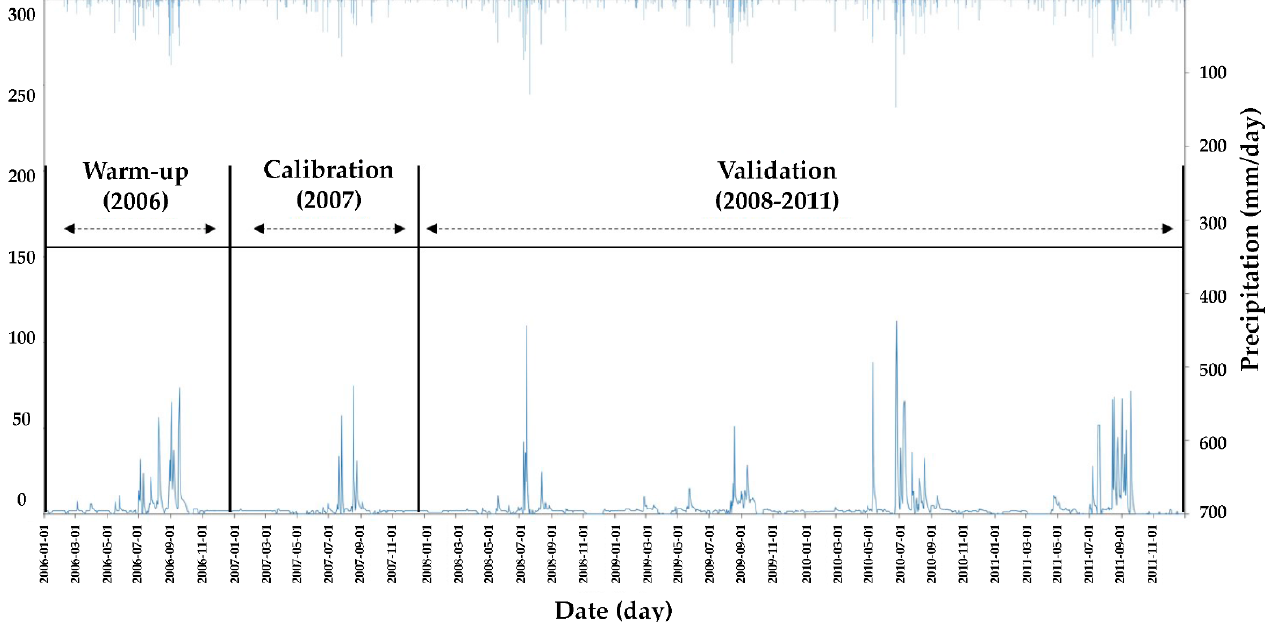
Table 3. Selected value for explanation and calibration of Soil and Water Assessment Tool (SWAT) model parameters. Parameters